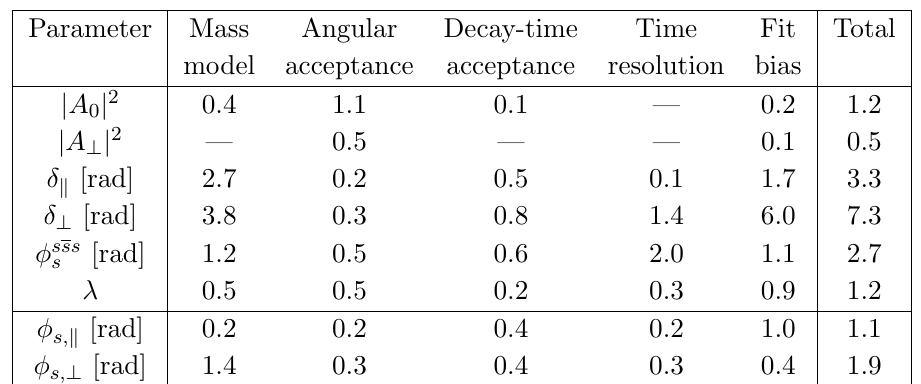
Table 5 . Summary of systematic uncertainties (in units of 10 (cid:0) 2 ) for parameters of interest in the decay-time-dependent